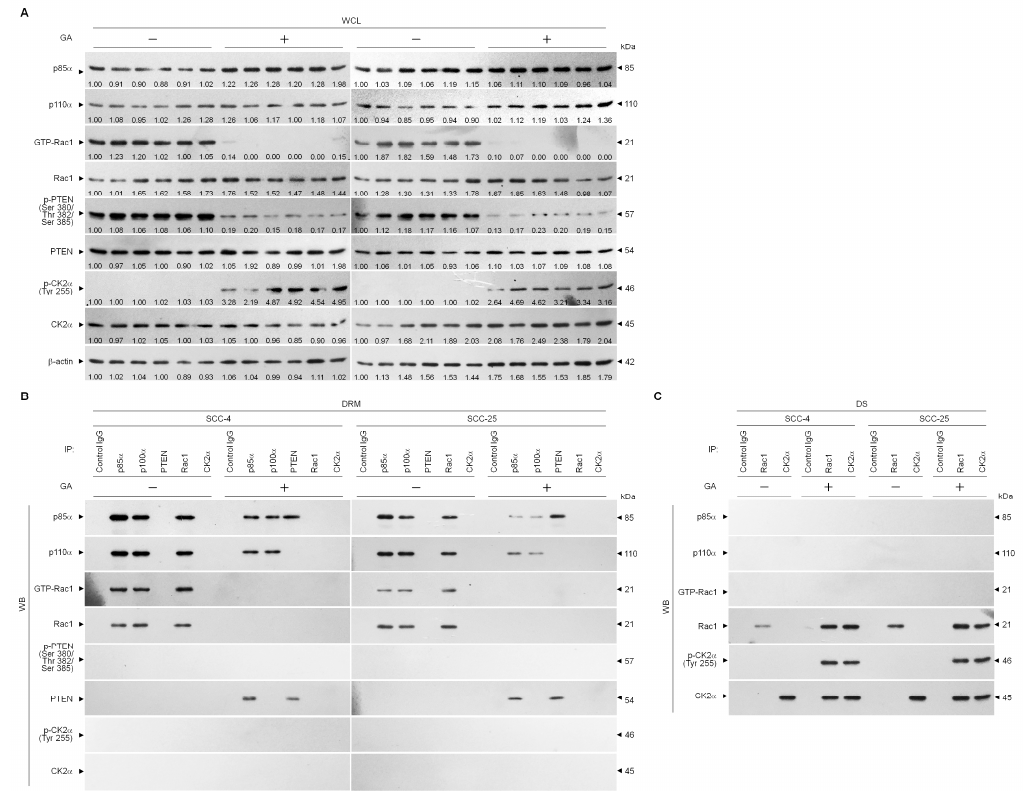
Figure 4. Gallic acid (GA) induces formation of inactive Ras-related C3 botulinum toxin substrate 1 (Rac1)–phospho (p)-casein kinase 2 α (CK2 α ) (Tyr 255) and lipid raft-associated p85 α